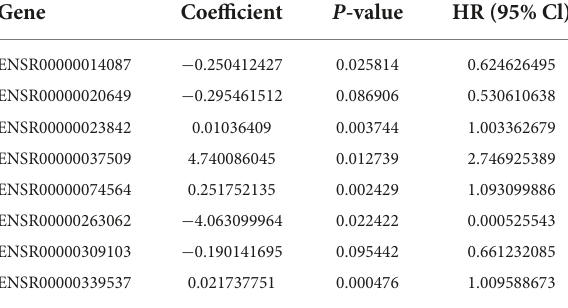
TABLE 1 Eight eRNAs in the risk